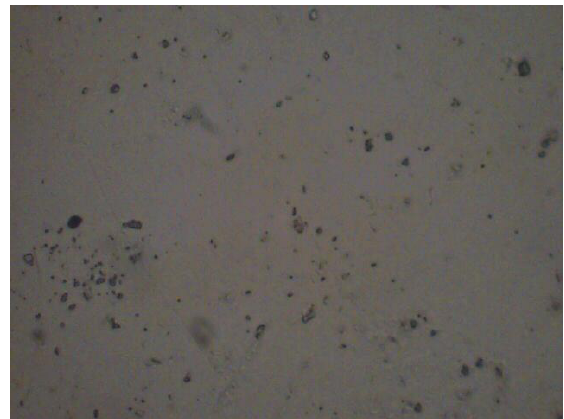
Fig. 2: Picture of track in Al.Wafaa